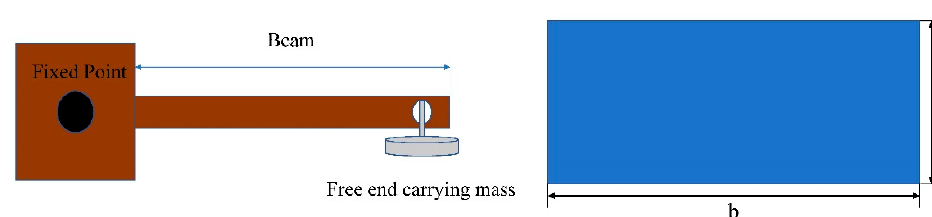
Figure 19. Cantilever beam with attached mass (bobbin) with free vibration (lumped mass) ( left ) and rectangular cross-section of the beam ( right ).